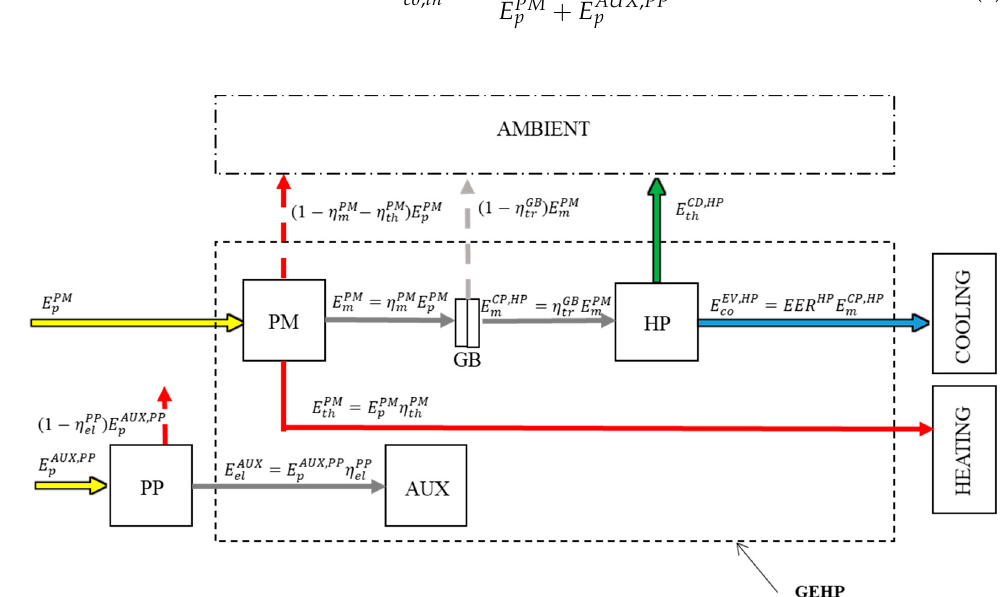
Figure 12. GEHP in combined heating and cooling